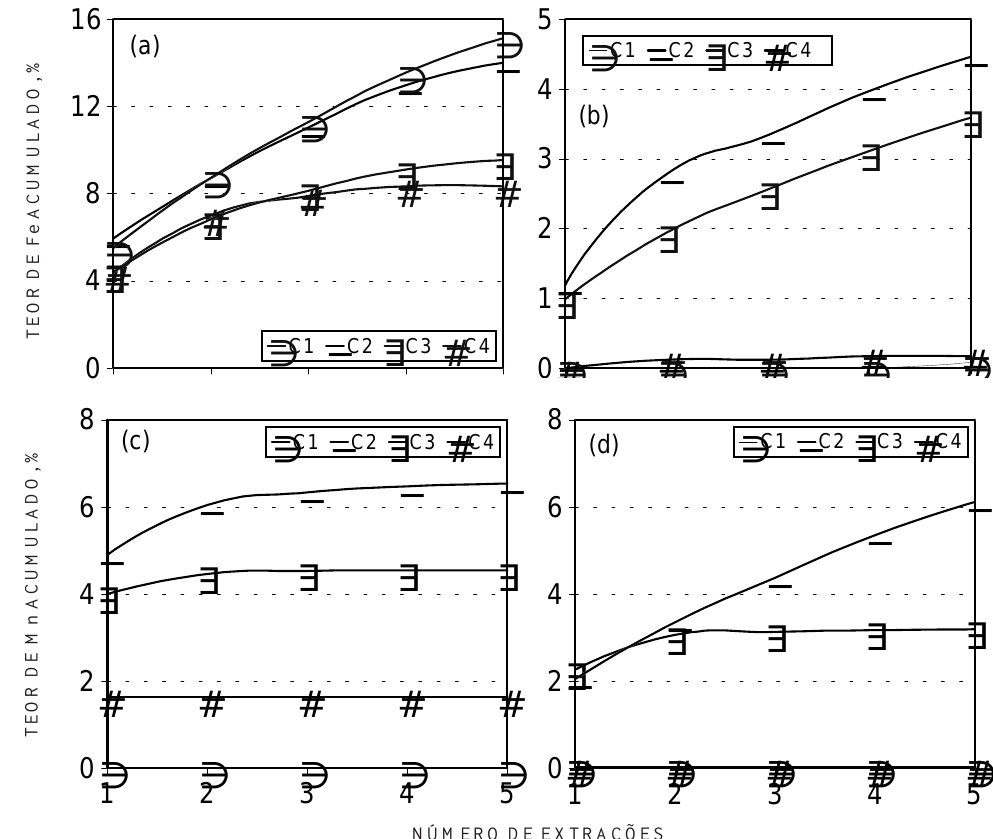
Figura 1. Curva dos teores de ferro e manganês resultantes de extrações sucessivas com DCB e oxalato das concreções de ferro e manganês. (a) Fe-DCB; (b) Fe-oxalato; (c) Mn-DCB; (d)